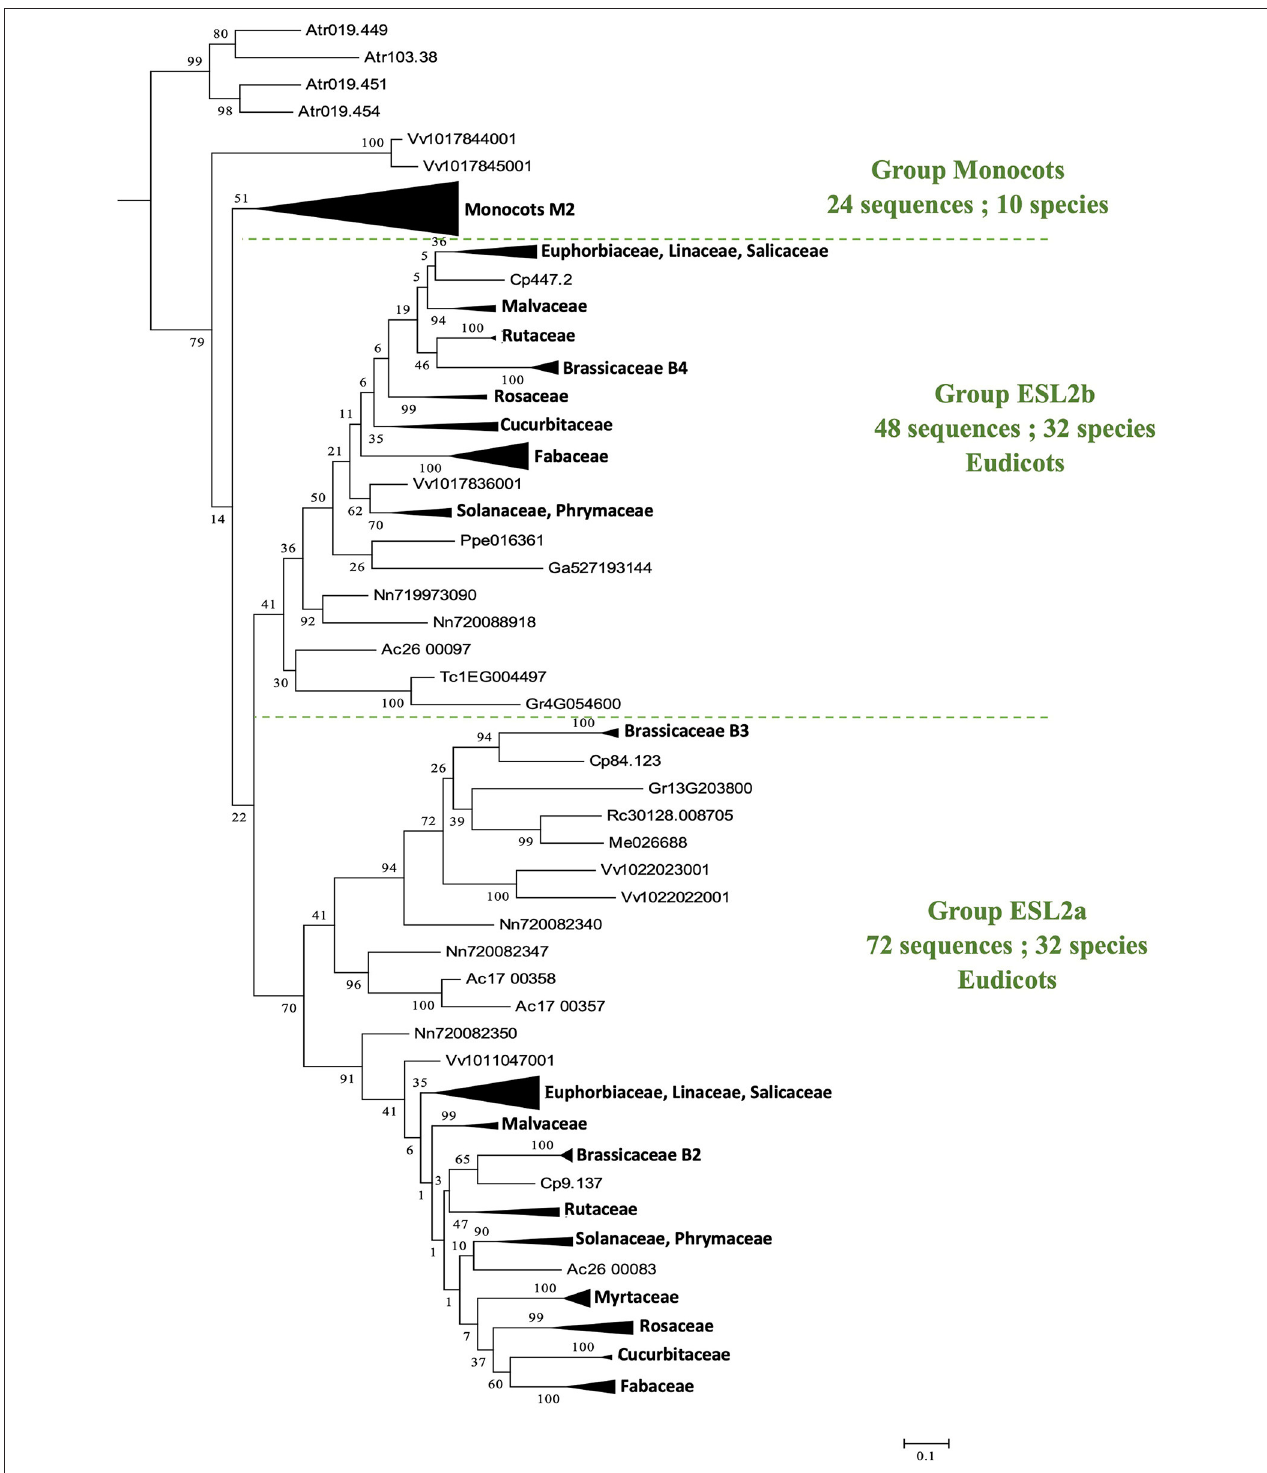
FIGURE 4 | The maximum likelihood phylogeny of ESL sugar transporter proteins: The details of group ESL2. The tree was produced by aligning 519 amino acid ESL sequences identified in 47 Embryophyta using ClustalW and was then built using the software Molecular Evolutionary Genetics Analysis (MEGAv6, Tamura et al., 2013). JTT amino acid substitution model was used and the bootstrap consensus tree was inferred from 1,000 replicates. The percentage of replicate trees in which the associated taxa clustered together in the bootstrap test is shown next to the branches. The tree is drawn to scale, with branch lengths measured in the number of substitutions per site. For the annotation of sequences, see Supplementary Table 1